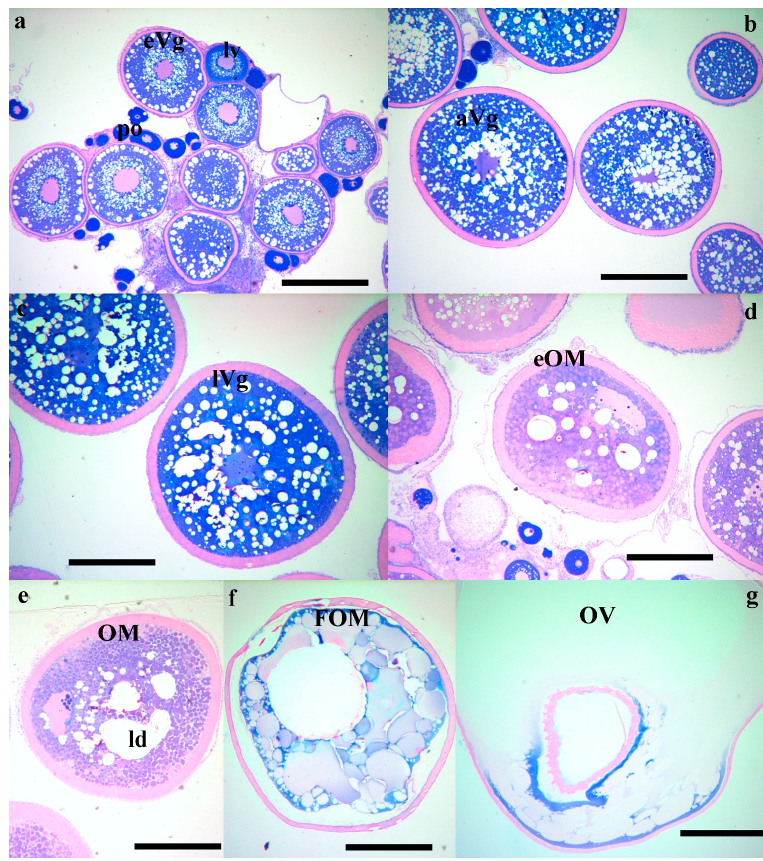
Figure 2. Photomicrographs of histological sections of wreckfish biopsies, showing: ( a ) primary (po), lipid vesicle (lv) and early vitellogenic oocytes (eVg); ( b ) advanced vitellogenic oocytes (aVg); ( c ) late vitellogenic oocytes (lVg); ( d ) early maturing oocytes with lipid droplet coalescence (eOM); ( e ) advanced maturation oocytes (OM) with further coalescence of the lipid droplets (ld); ( f ) oocytes at the FOM stage; and ( g ) ovulated oocytes (OV). Histological sections were stained with methylene blue/basic fuchsin, and the bar is 500 μ m.